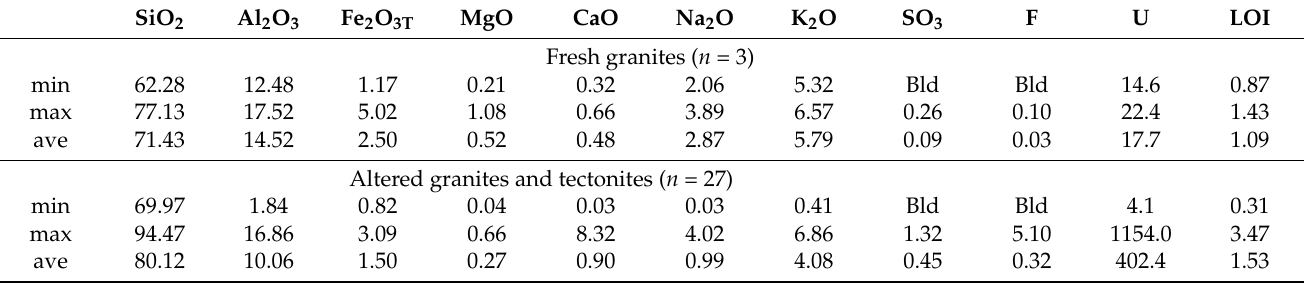
Table 2. Geochemical summary of major-element oxides (wt%) and U (ppm) of SJOF granite samples. SiO 2 Al 2 O 3 Fe 2 O 3T